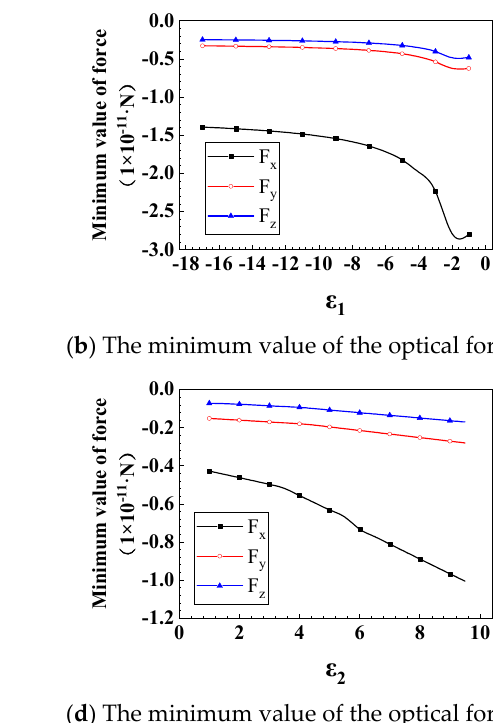
( a ) The maximum value of the optical force ( b ) The minimum value of the optical force Figure 10. The maximum and minimum values of optical force varies with θ 0 . ( a , b ) show the change Figure 10. The maximum and minimum values of optical force varies with 0 rules of the maximum and minimum values of F x , F y , and F z in the process of θ 0 increasing from change rules of the maximum and minimum values of x 0 ◦ to 180 ◦ . ° ° increasing from 0 to 180 .